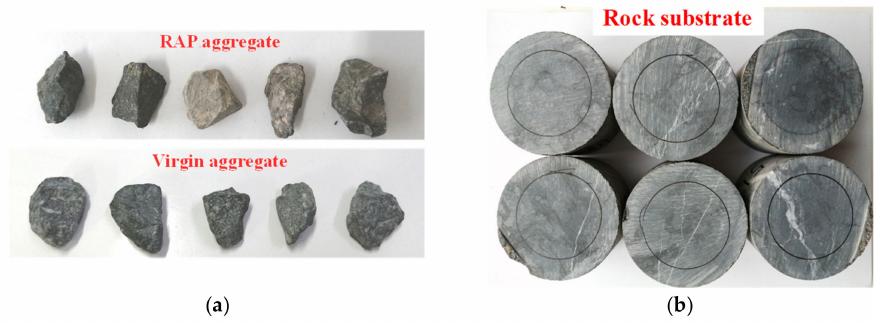
Figure 2. Aggregates and rock substrate for testing. ( a ) aggregate; ( b ) rock